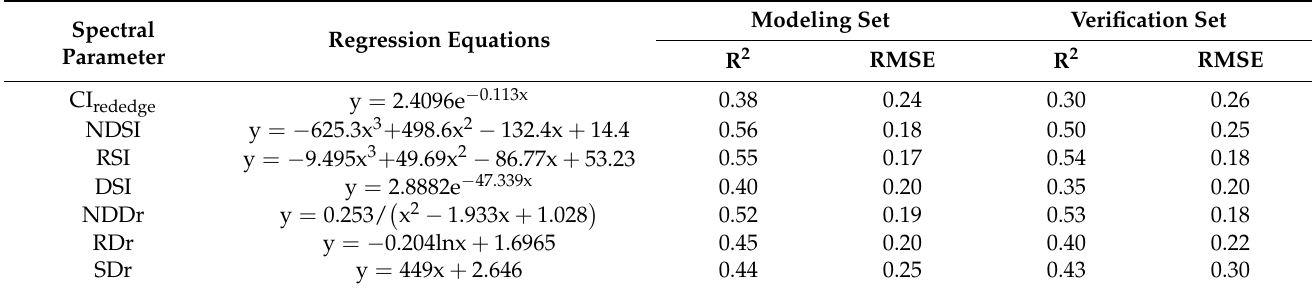
Table 4. Estimation model of CNC based on the single spectral